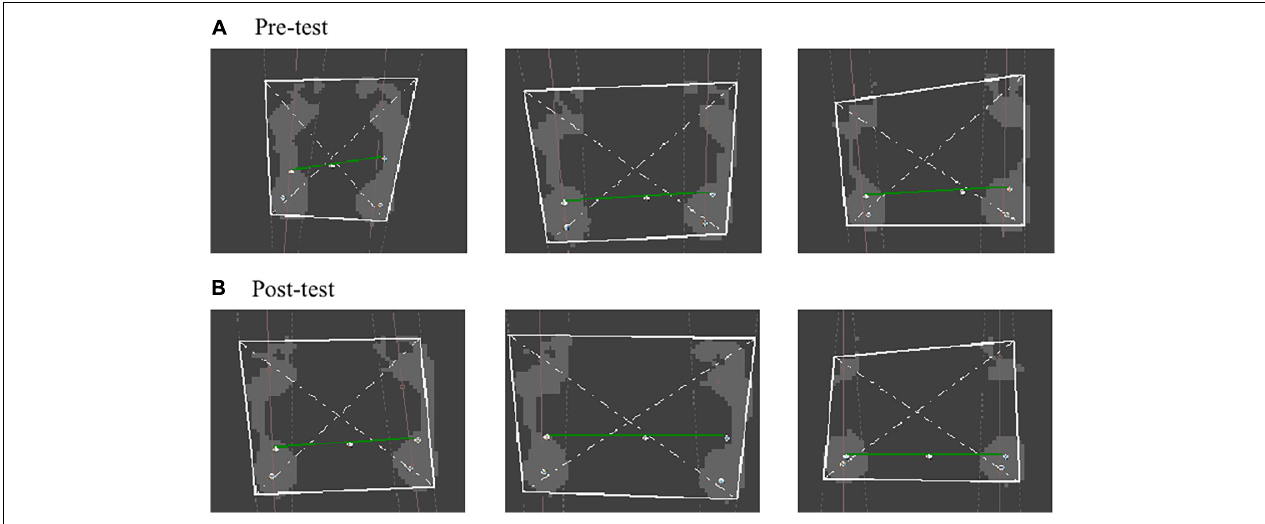
FIGURE 3 | Connecting diagram of static plantar pressure center. (A) Pre-test of connecting diagram of static plantar pressure center. (B) Post-test of connecting diagram of static plantar pressure center. TABLE 3 | Pre-test and post-test of dynamic plantar pressure parameters. Pre-test Post-test Area (cm 2 ) Load (%) Area (cm 2 ) Load (%) Left foot Right foot Left foot Right foot Left foot Right foot Left foot Right